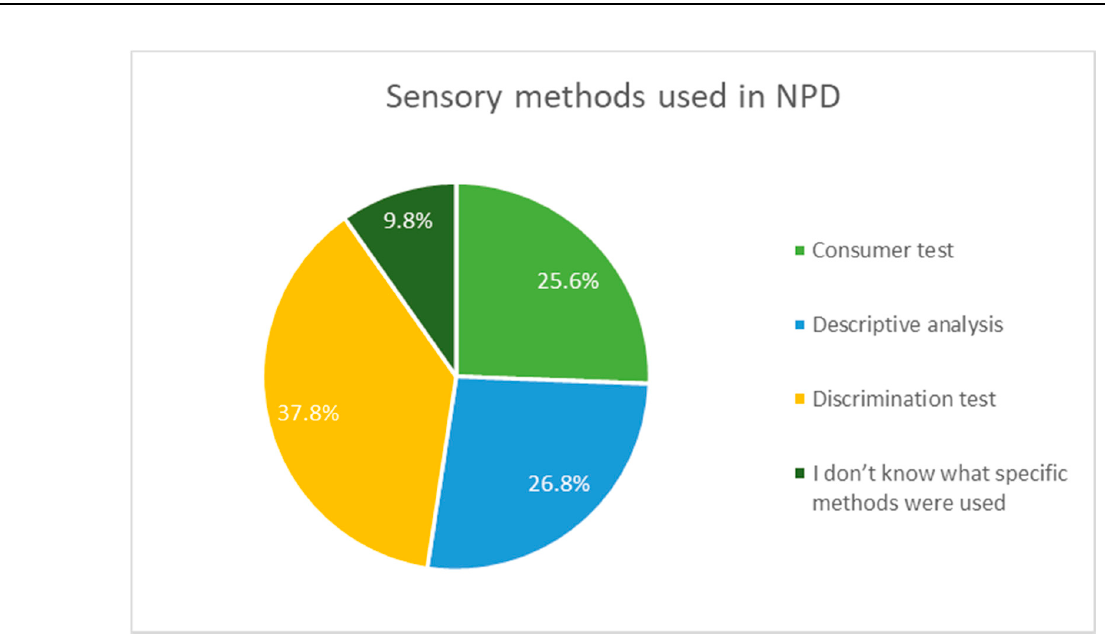
Figure 1. Sensory methods used in NPD.